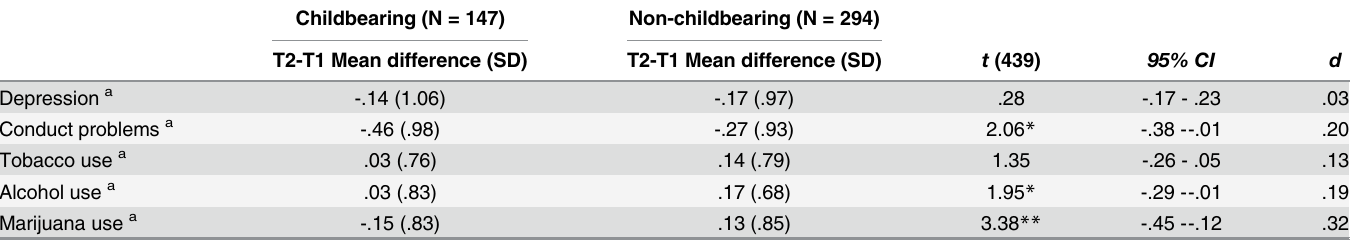
Table 3. Change in symptom severity and frequency or substance use between T1 and T2 by childbearing and non-childbearing